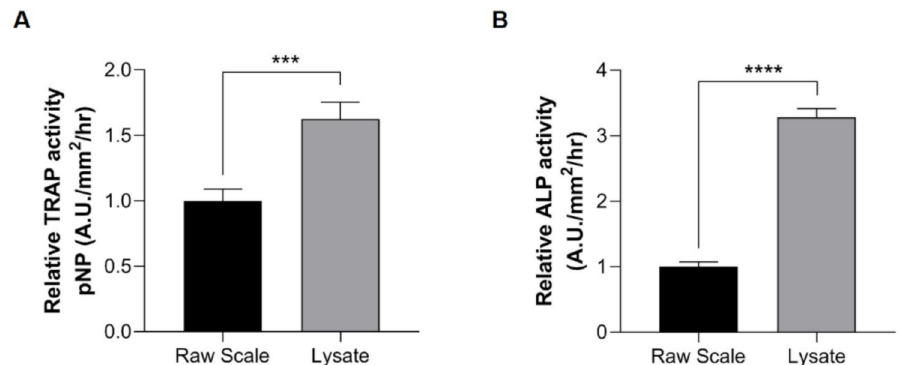
Figure 4. Determination of enzyme activities using raw scales (black bar) and lysate (gray bar). ( A ) TRAP activity and ( B ) ALP activity. Lysate samples (gray bar) exhibit high activity levels compared with raw scale samples (black bar). Comparisons between the two groups were performed by Student’s t -test. The comparison of the methods was tested by the unpaired t -test method. Data are shown as the mean ± SEM (**** p ≤ 0.0001; *** p ≤ 0.001). Error bars indicate the standard error of the mean.